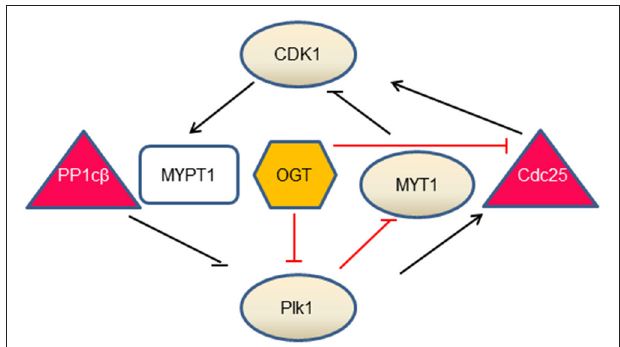
FIGURE 1 | The interlinked network between O-GlcNAc and mitotic kinases. Our current understandings comprise three branches. During mitosis, CDK1 phosphorylates MYPT1 to promote its interaction with Plk1. MYPT1 recruits PP1c β to dephosphorylate and inactivate Plk1 (71). In the second branch, OGT decreases Plk1 protein levels, which further increases MYT1 levels and decreases MYT1 phosphorylation. As MYT1 inhibits CDK1 by phosphorylation, OGT thus promotes inhibitory phosphorylation of CDK1. In the third branch, OGT inactivates CDK1, via down-regulating the mRNA levels of Cdc25-the activating phosphatase of CDK1 ( 50). Whether OGT is enmeshed in the MYPT1 branch is not understood. Kinases are in circles, phosphatases are in triangles, MYPT1 is in a square and OGT is in a hexagon. Lines in black denote direct effects (phosphorylation or dephosphorylation), and lines in red demarcate indirect effects (mRNA or protein